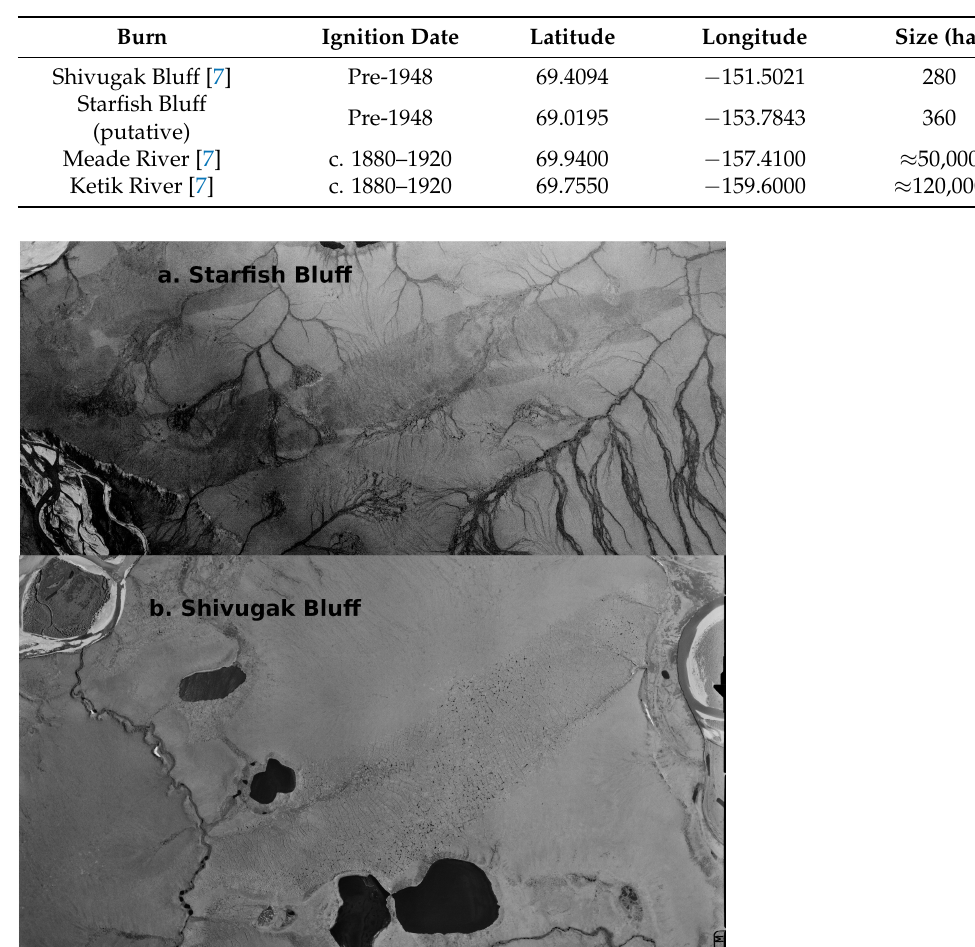
Table 3. Prehistoric burn attributes.